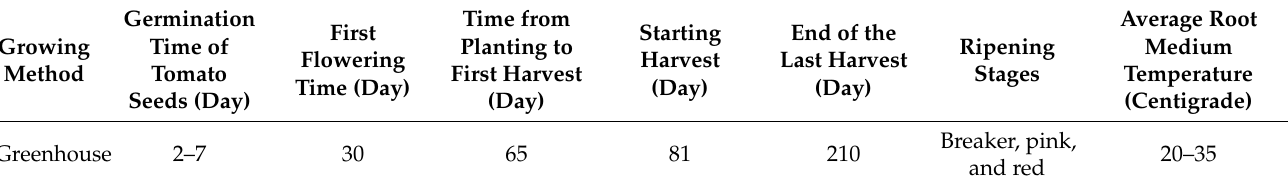
Table 3. A typical example of a tomato growth cycle [52,53].